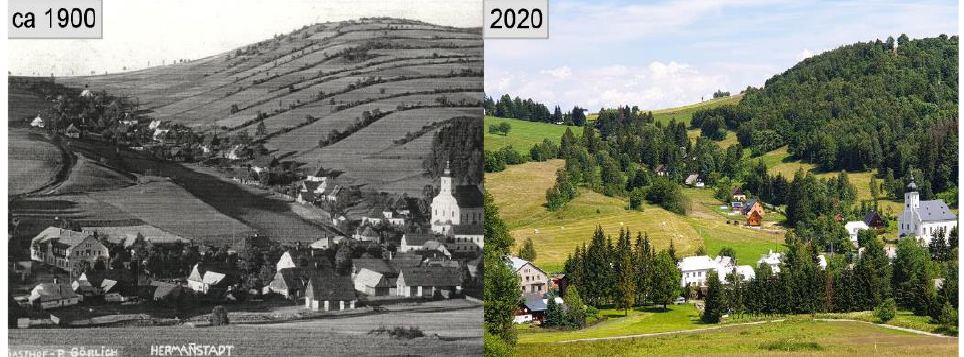
Figure 8. Spread of woody vegetation at the Heřmanovice site (Jeseníky Mts): on the left, historical postcard from the beginning of the 20th century; on the right, contemporary photo [sources: personal archive of Riezner; Zacharová, 2020].